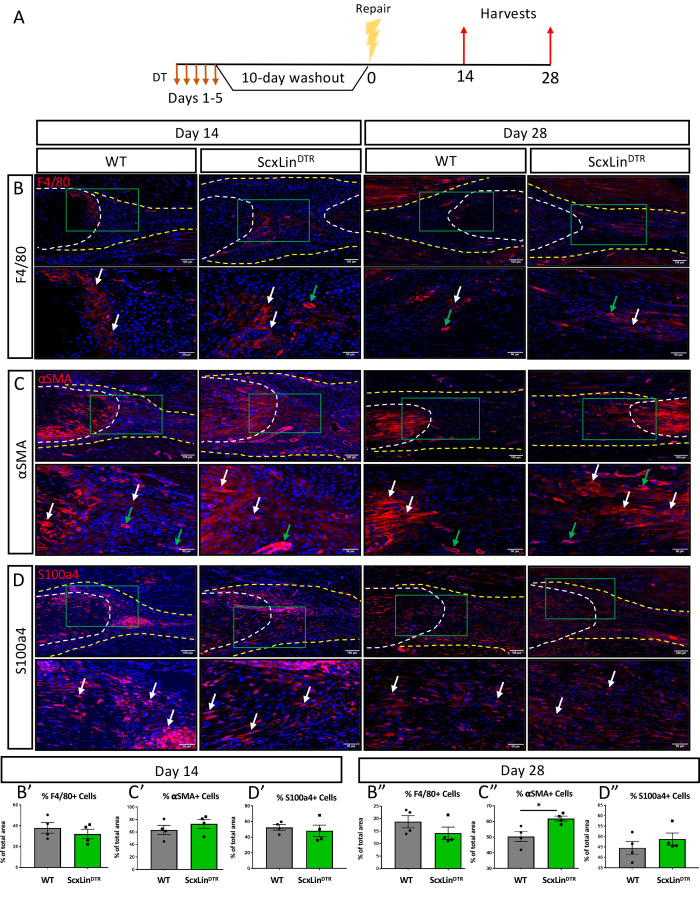
ScxLinDTR repaired tendons heal with increased presence of αSMA+ myofibroblasts.Mice received five hindpaw injections of DT on consecutive days, underwent flexor tendon repair surgery 10 days after the final DT injection, and were harvested at 14 and 28 days post-repair (A). Immunofluorescence of WT and ScxLinDTR repair tendons 14 and 28 days post-repair to assess F4/80+ macrophages (B), αSMA+ myofibroblasts (C), and S100a4+ cells (D). Tendon is outlined by white dotted line and scar tissue by yellow dotted line. Green boxes indicate location of higher magnification images. Examples of positive stain indicated by white arrows, while examples of auto-fluorescent blood cells and α-SMA+ blood vessels indicated by green arrows. Quantification of F4/80 (A’ and A’’), αSMA (B’ and B’’), and S100a4 (C’ and C’’) fluorescence. N = 4 per genotype per timepoint. Student’s t-test used to assess statistical significance between genotypes at a given timepoint, except for D28 F4/80 and S100a4 which required a Mann-Whitney test. * indicates p<0.05.